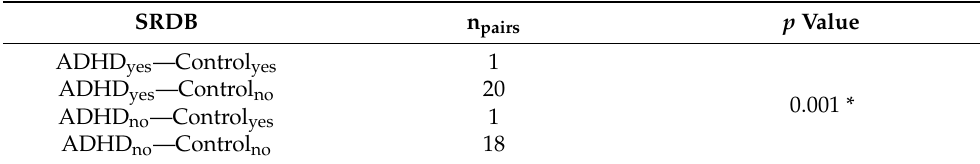
Table 5. Comparison of sleep-related breathing disorder in ADHD and control group (ADHD = 40, controls =